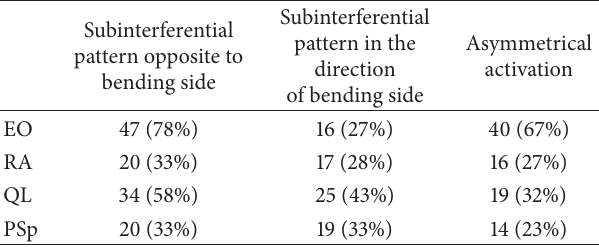
Table 2: Summary of muscle activation data during MVMC.